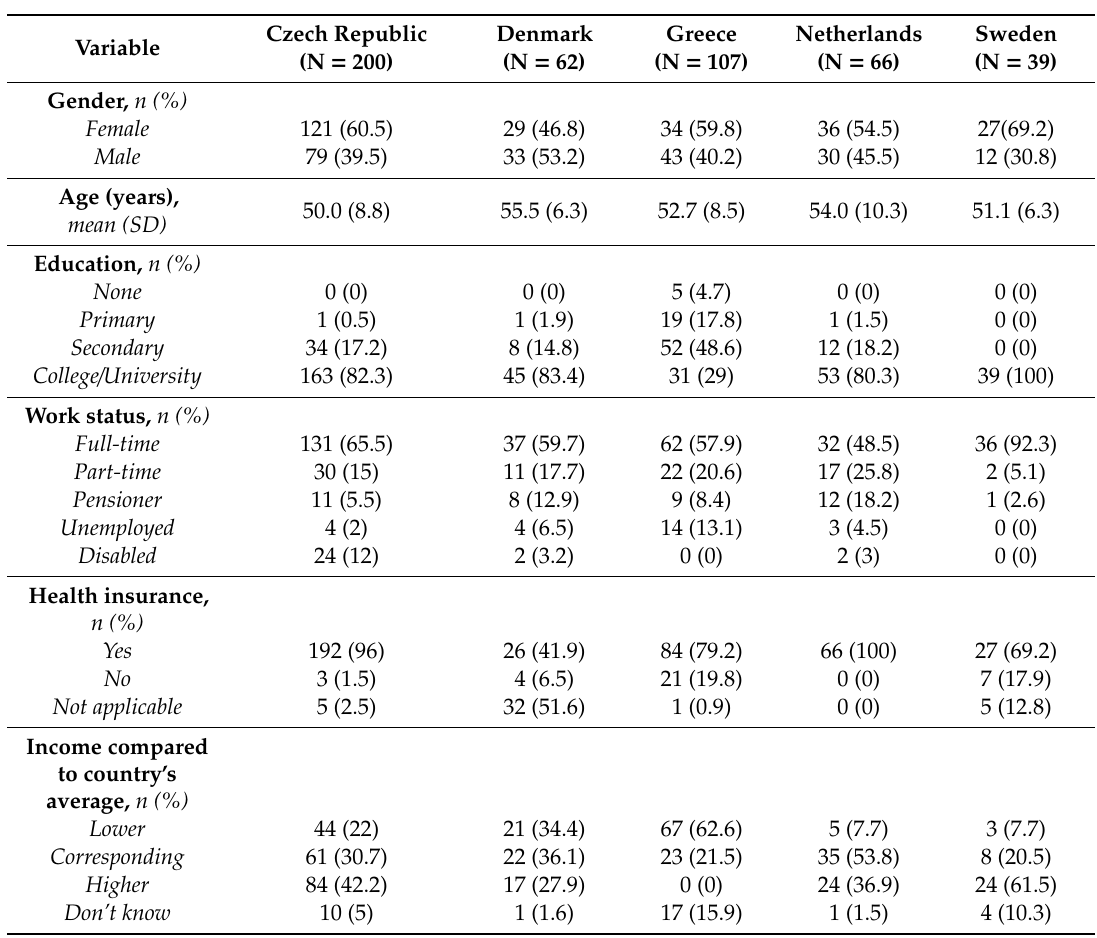
Table 1. Demographic characteristics of individuals accepting the invitation per